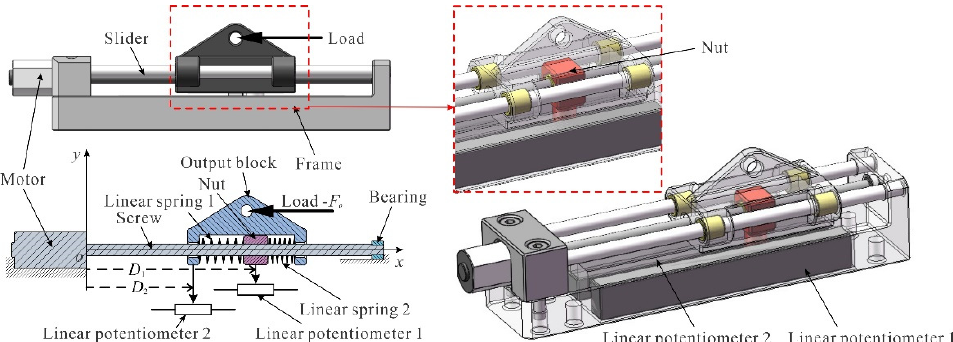
Figure 1. The composition of the linear series elastic actuator.